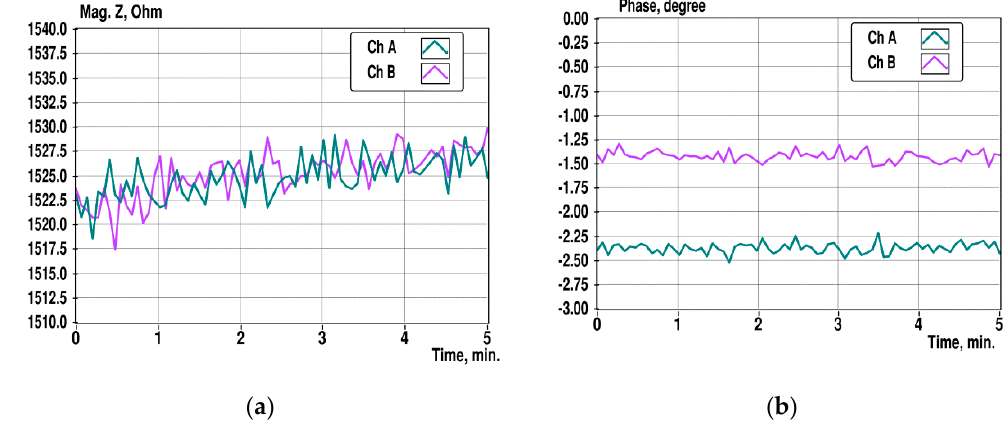
Figure 17. Changes of the impedance magnitude ( a ) and phase ( b ) at 10 kHz during 5 min observation in sensor channels A and B filled with PBS.